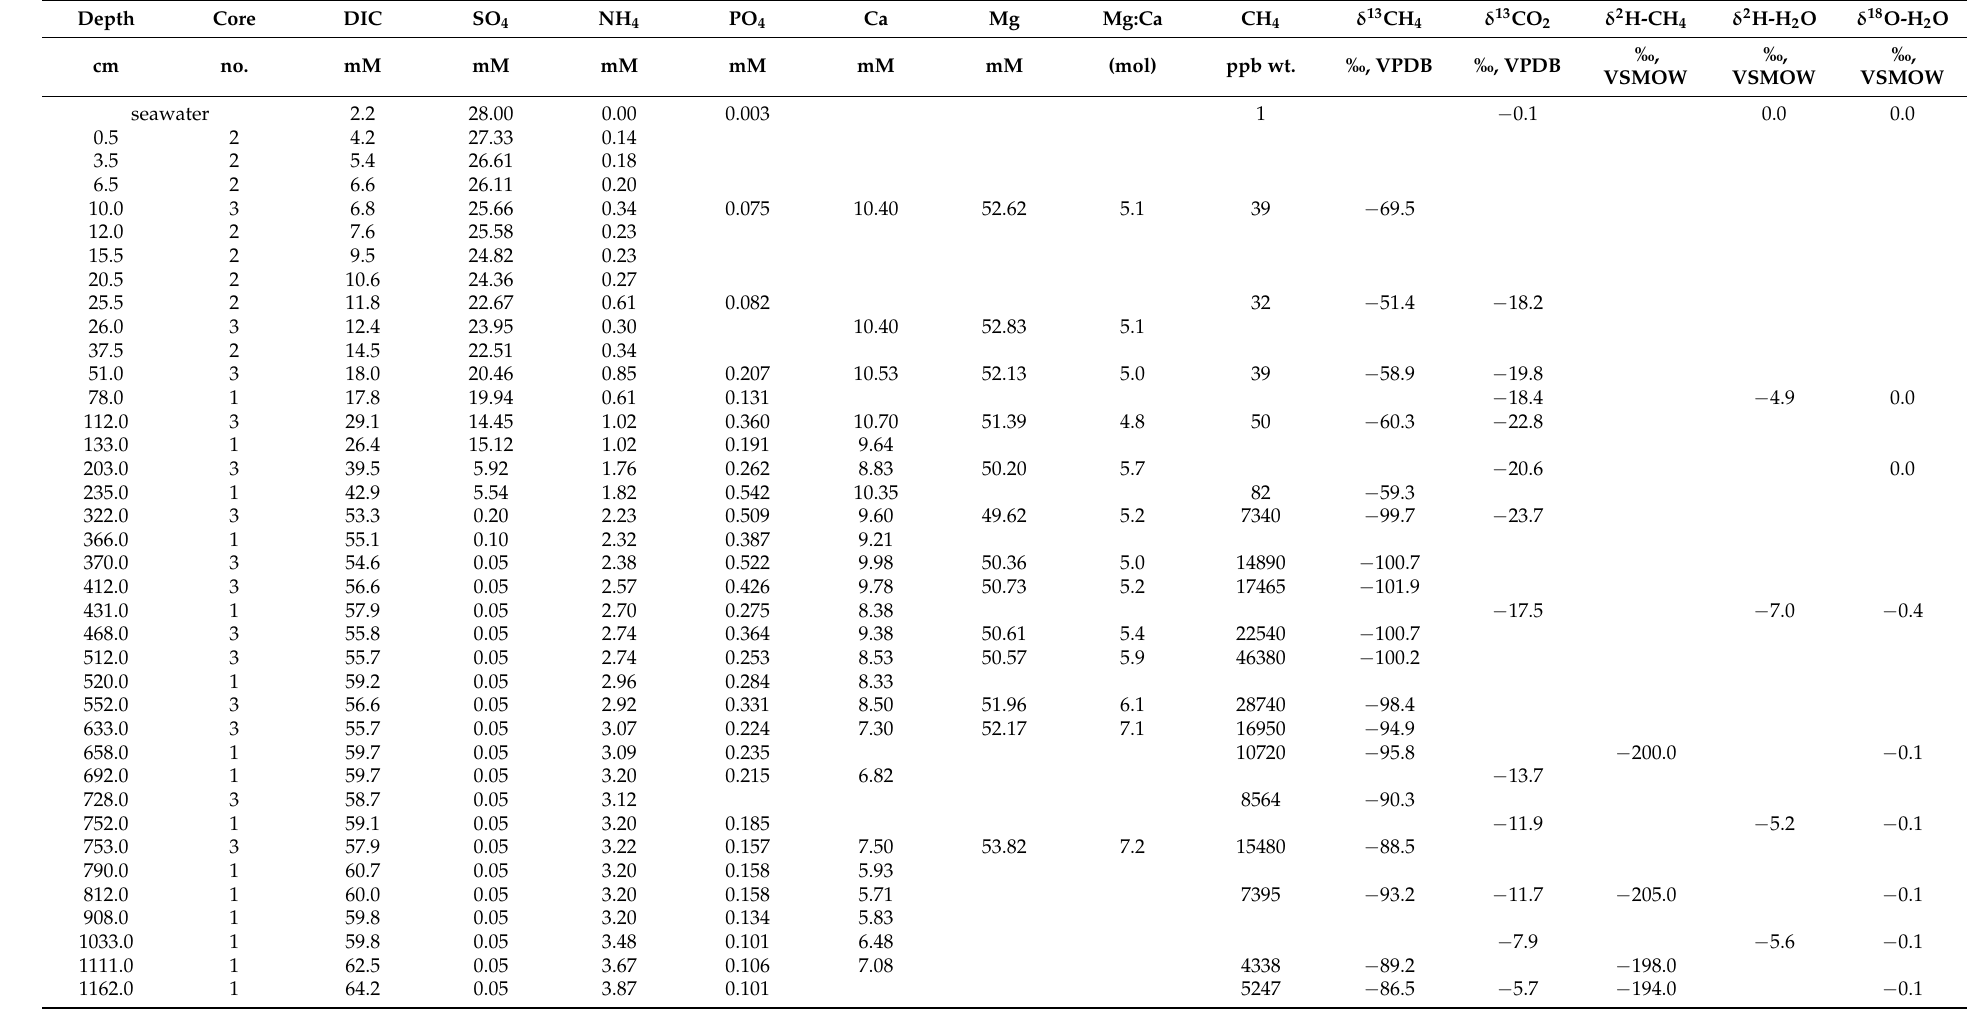
Table 1. Chemical composition of interstitial fluids and gases in Bransfield Strait cores ANT 1138-4 (1), 1324-2 (2), and 1327-1 (3).